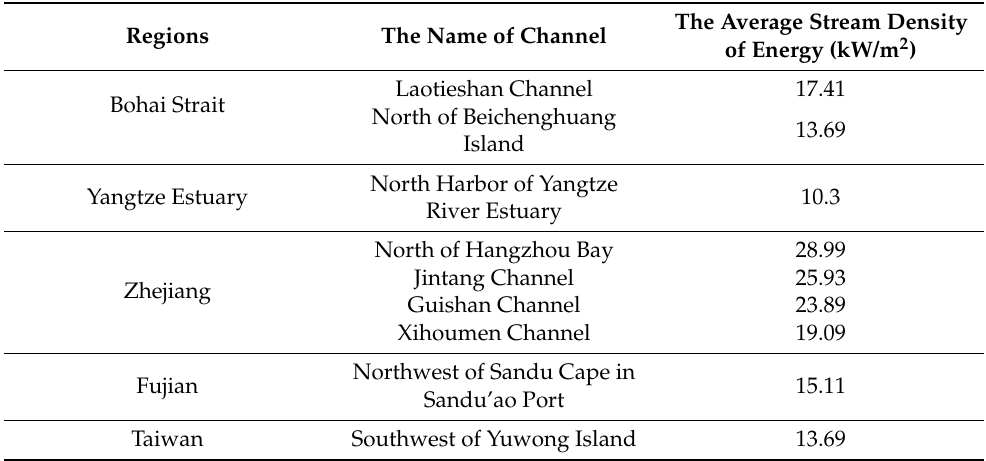
Table 2. Channel statistics of high energy current density along the coast of China in 1986 national assessment